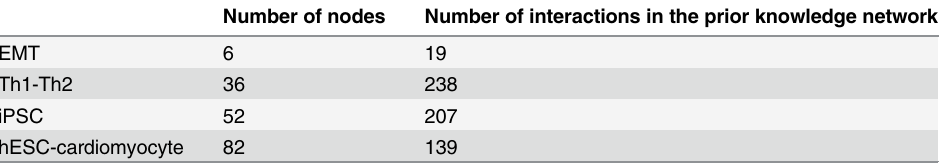
Table 1. Applied case